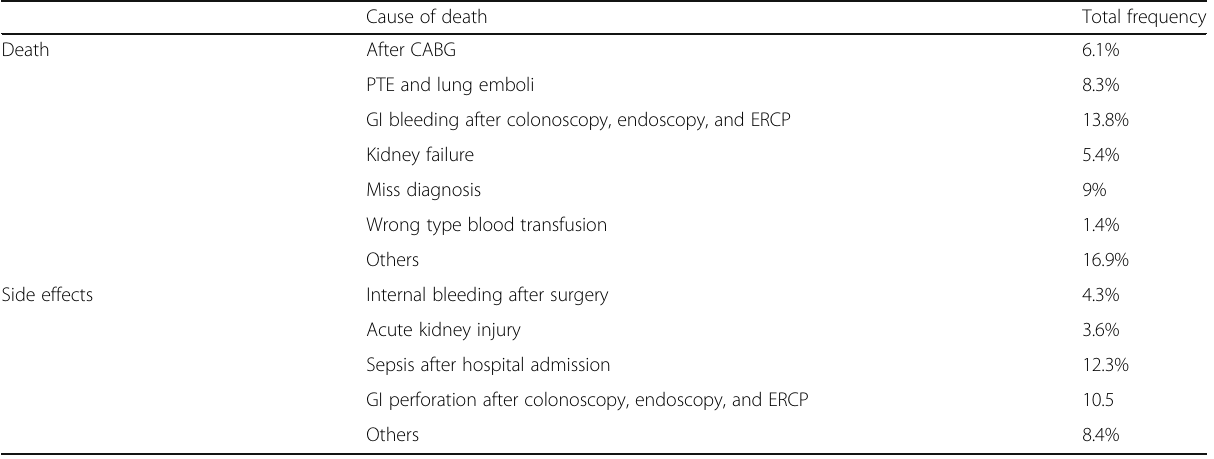
Table 2 Frequency distribution percentage of the plaintiffs ’ side effect and death according to the type of side effect and